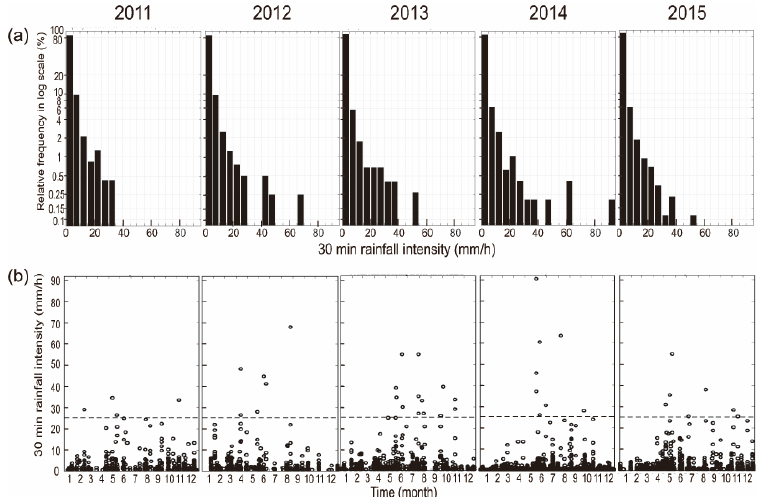
Figure 1. Precipitation characteristics for the study period. ( a ) Relative frequency distribution of 30 min rainfall intensity for each year. ( b ) Time series of 30 min rainfall intensities (mm h − 1 ). The horizontal dotted line indicates the infiltration capacity for the grassland watershed.